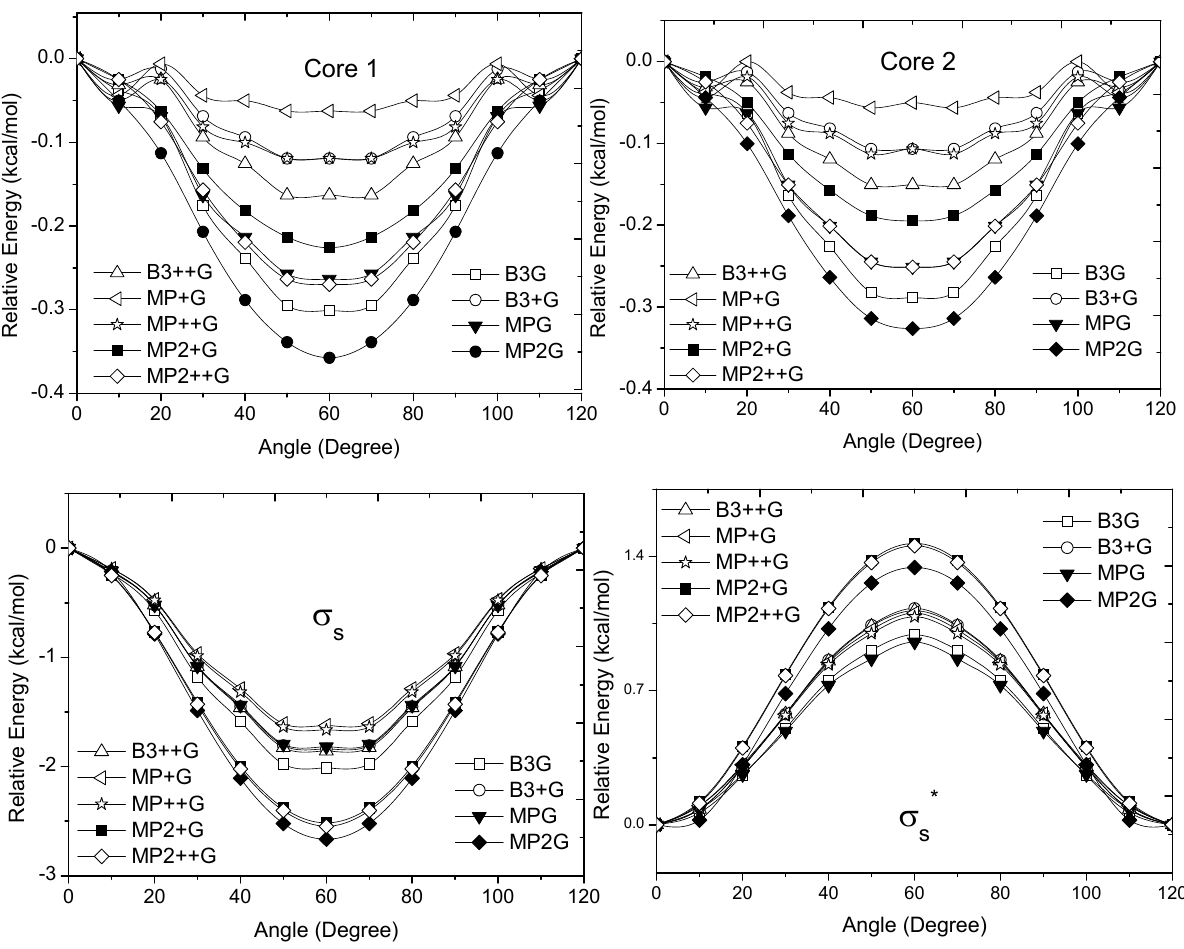
Figure 2. Energy of the core, and occupy MOs of ethane as a function of the rotational angle, calculated with the entire theoretical model studied in this work. Labels B3, MP correspond to the B3LYP and mPWB95 functionals, MP2 correspond to HF theory and the symbols G, +G, and ++G represent the basis set 6-31G(d, p), 6-31+G(d, p), and 6-31++G(d, p),